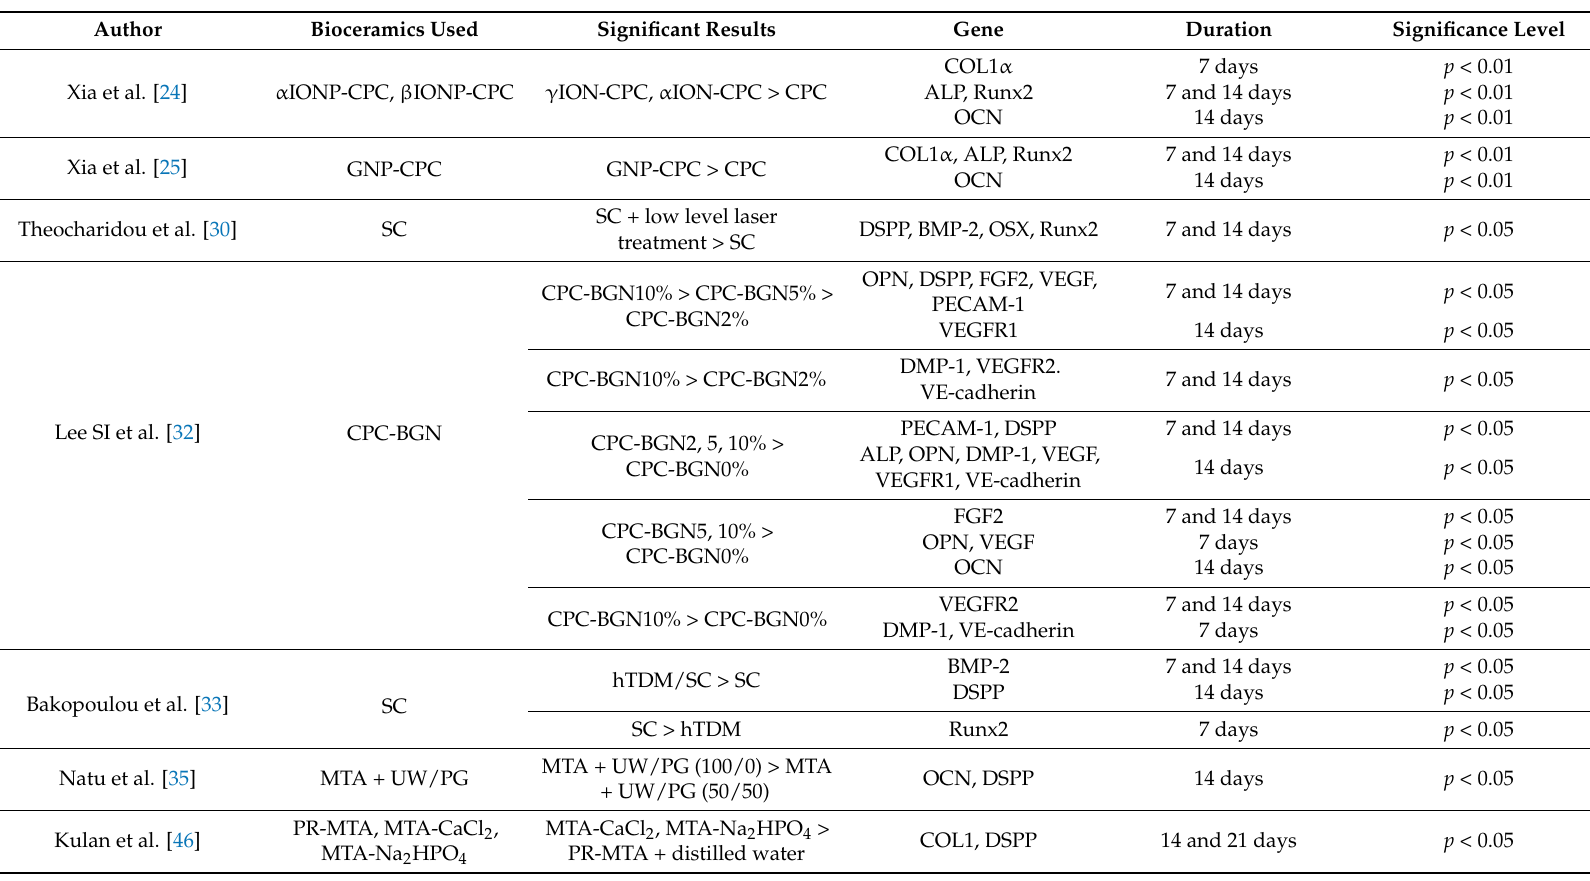
Table 8. Summary of the results of included studies showing significant differences between a bioceramic material with an additive and the bioceramic material itself for osteogenic, odontogenic and/or angiogenic gene